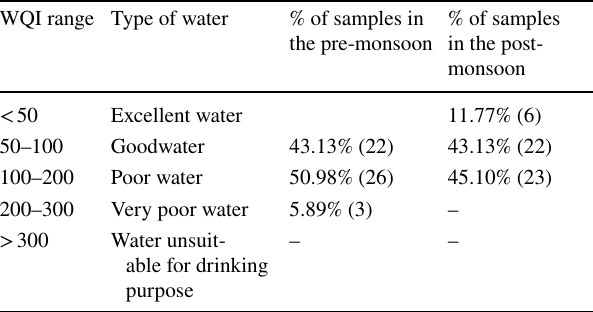
Table 5 Classification of water based on WQI in percentage WQI range Type of water % of samples in